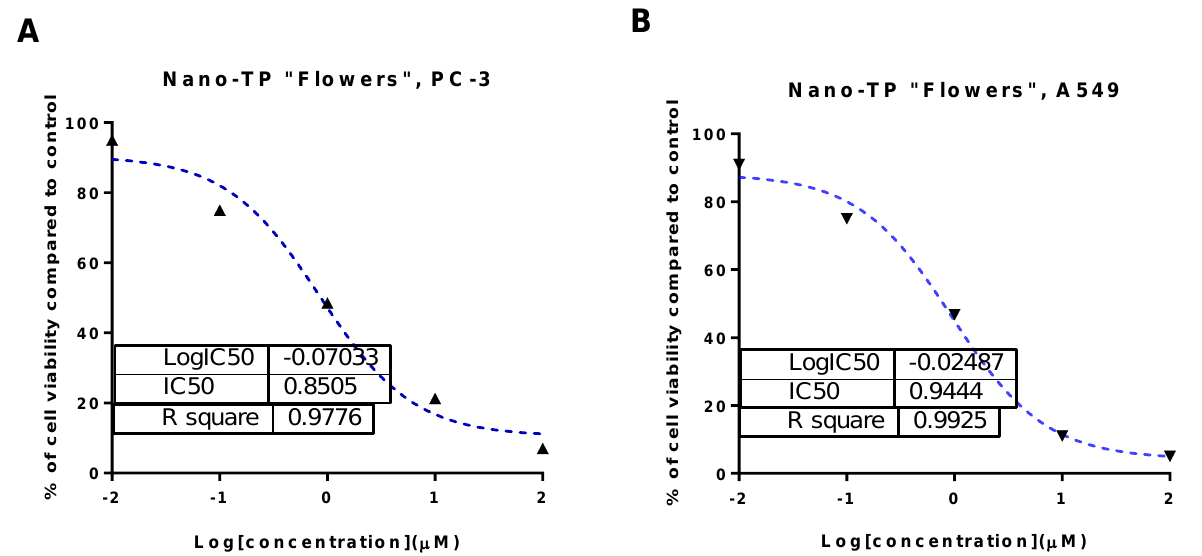
Figure 4. Percentage of cell viability vs. log [con. µ M], R square ≈ 1 using the GraphPad prism soft- ware: ( A ) cytotoxicity of Nano-TP/Flowers against PC-3 cells; ( B ) cytotoxicity of Nano-TP/Flowers against A549